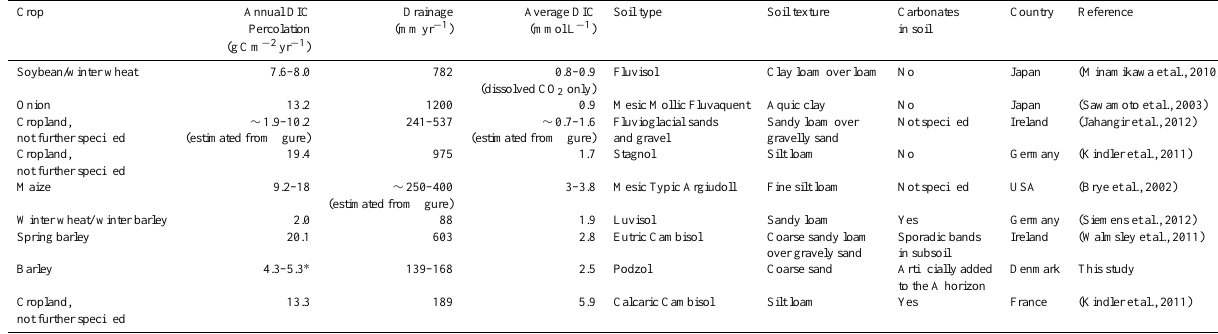
Table 4. Dissolved inorganic carbon (DIC) percolation fluxes from different types of cropland.